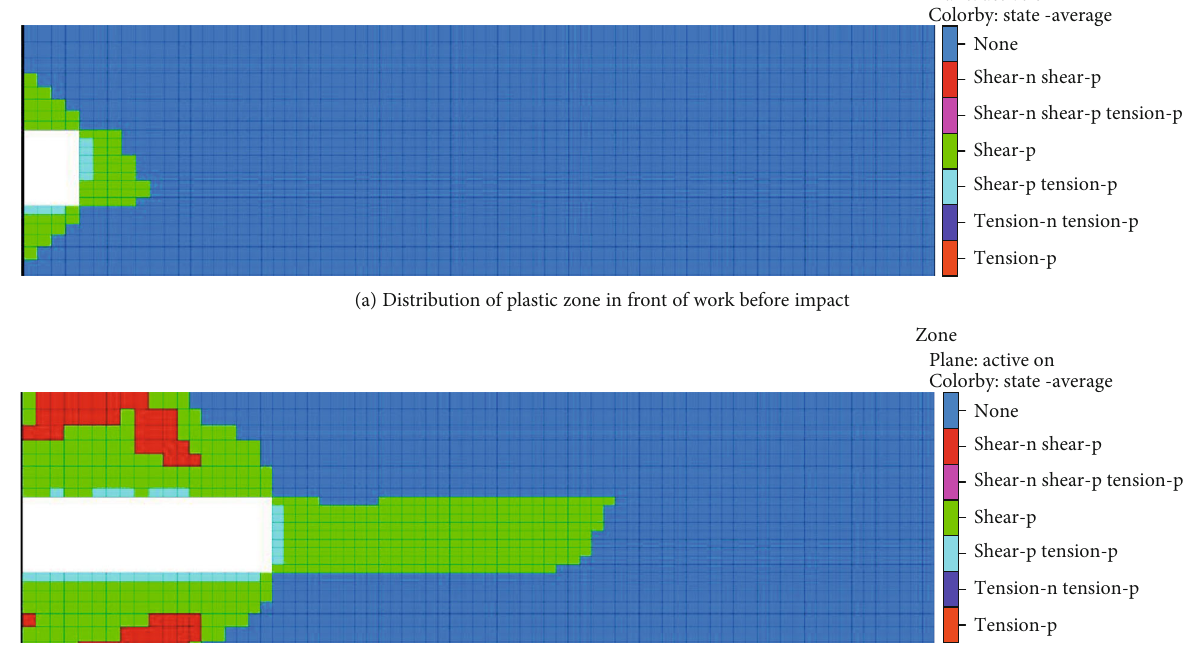
Figure 8: Change of plastic zone in working face a ff ected by